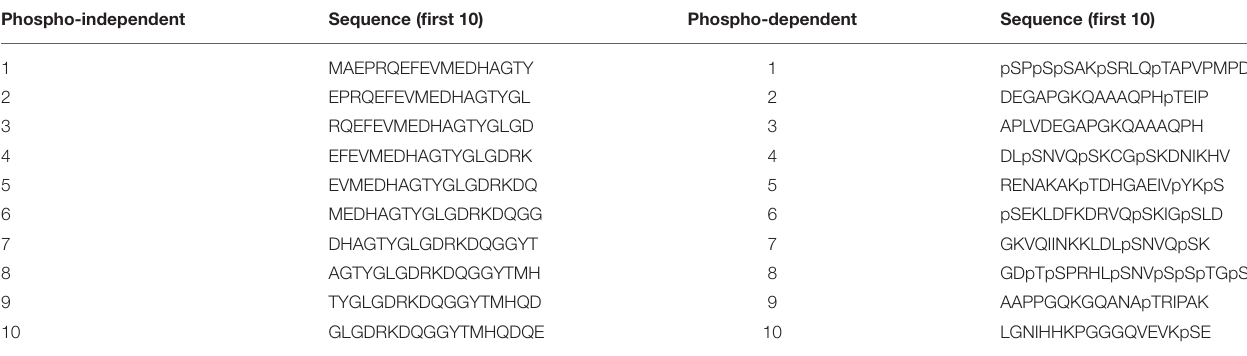
TABLE 1 | Different sets of peptides used for epitope mapping and phosphorylation-dependence studies. Phospho-independent